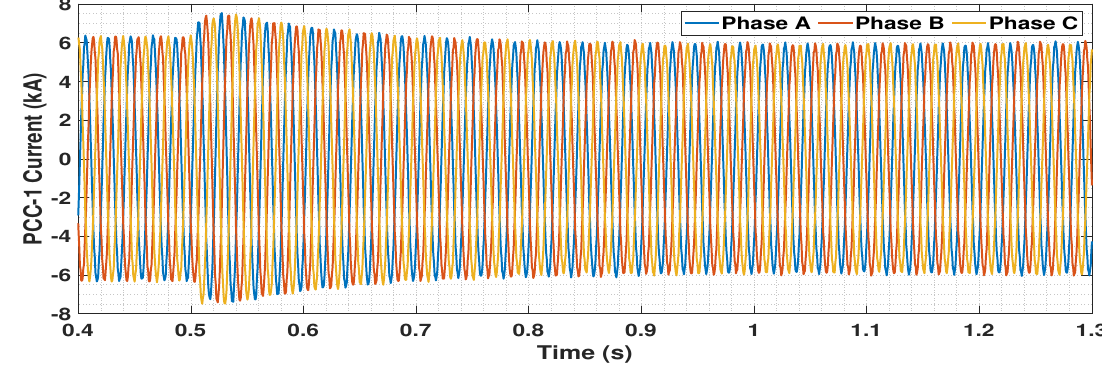
Figure 29. Currents at PCC-1 upon OWF-2 disconnection event.